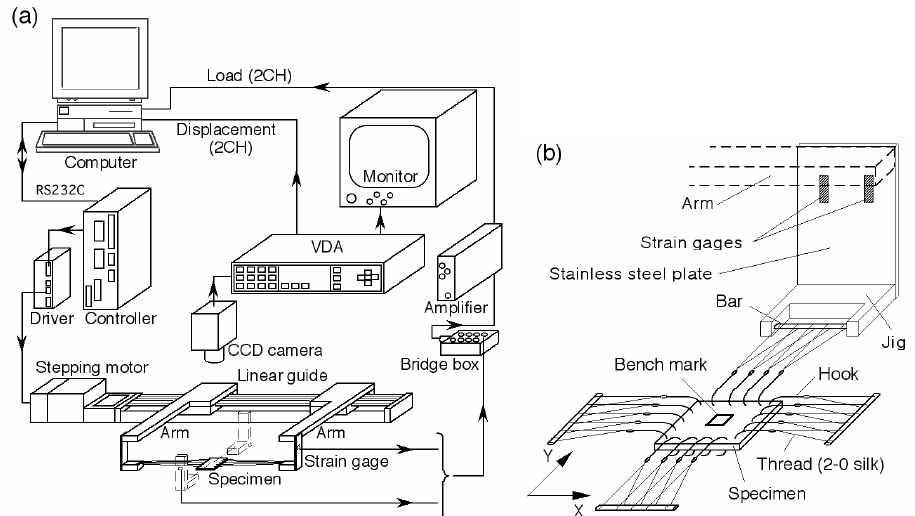
Fig. 1 Schematic representation of the 2 dimensional tensile test system (a) and the details of specimen chucking (b). VDA, video dimension